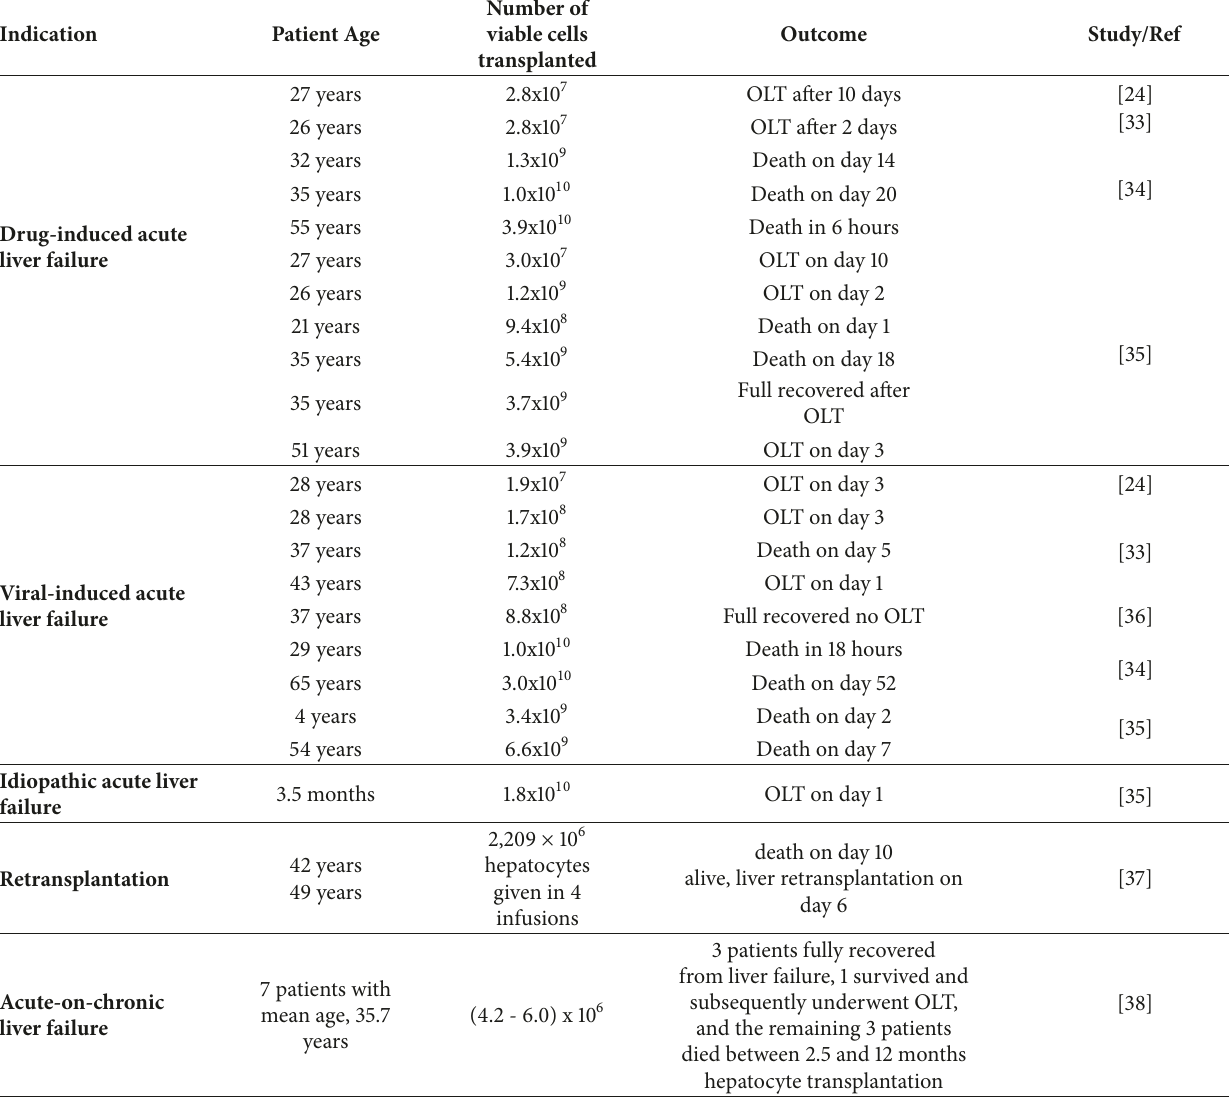
Table 2: Human hepatocyte transplantation for patients with acute liver